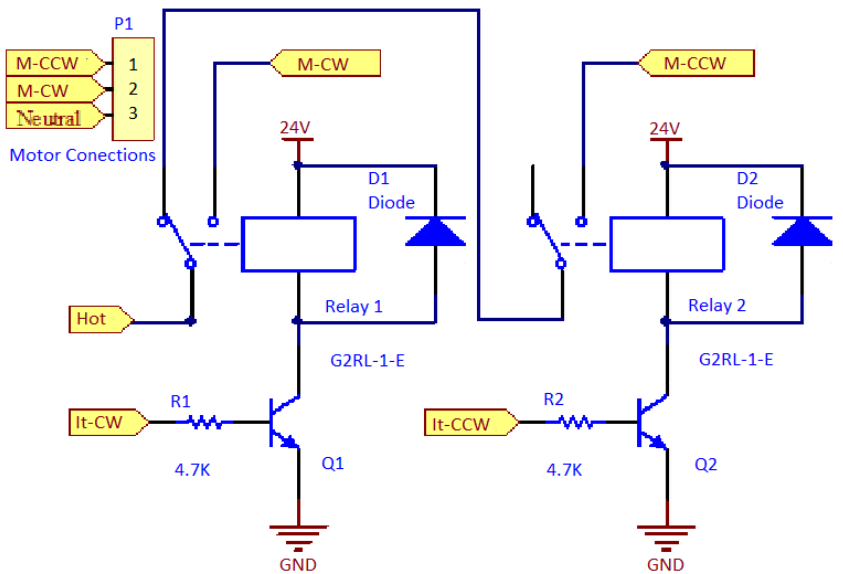
Figure 25. Electrical circuit diagram for the control of the punching motor